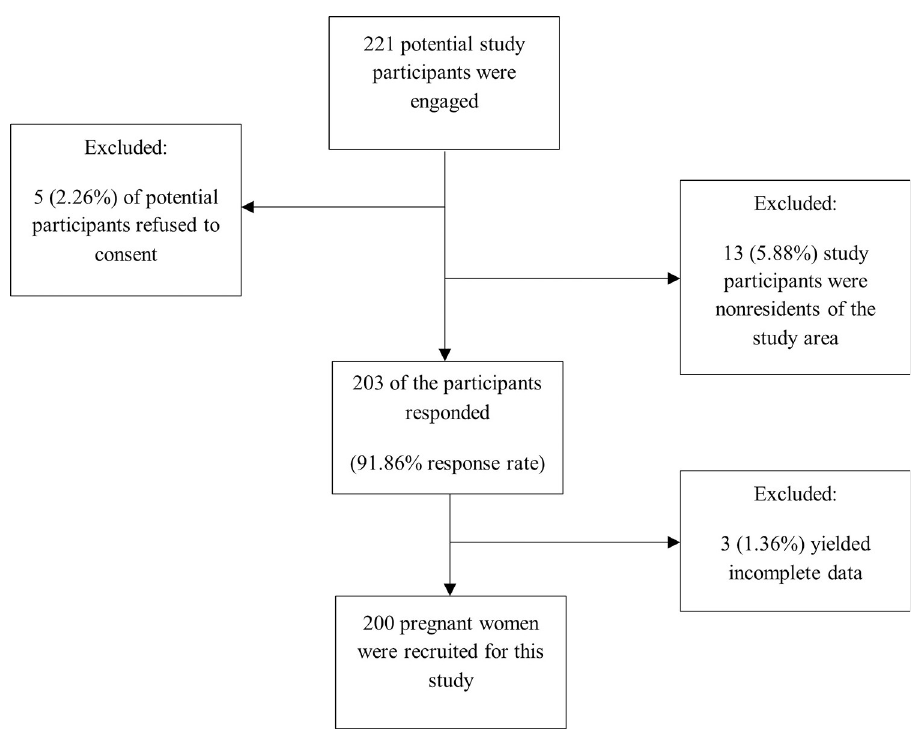
Fig 1. Flow diagram of recruited pregnant women included in the